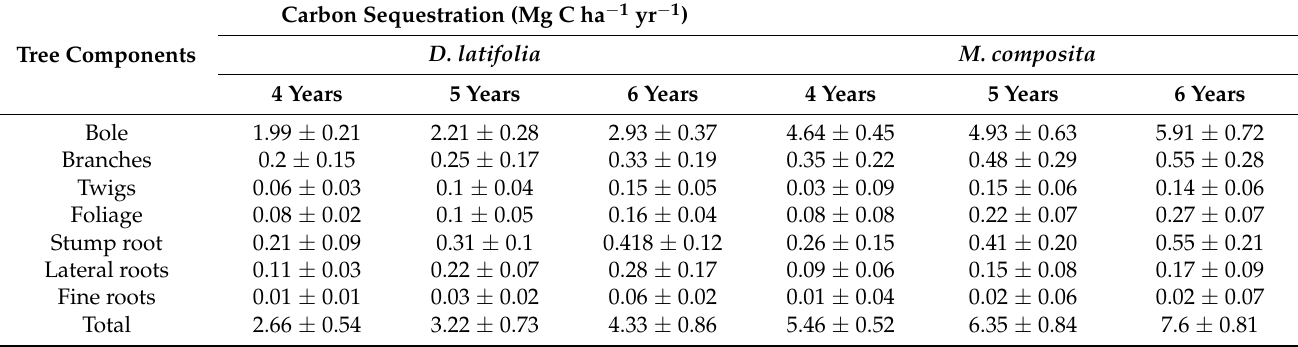
Table 9. Component-wise mean ± SE carbon sequestration (Mg C ha − 1 yr − 1 ) in both the plantations.